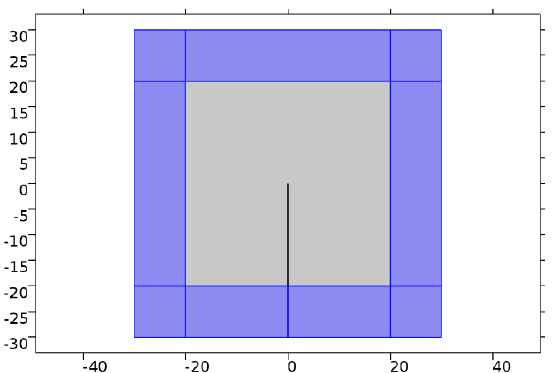
Figure 2. Finite Element Method (FEM) model with sound barrier and Perfectly Matched Layer (Violet color). Axes are in meters (m).